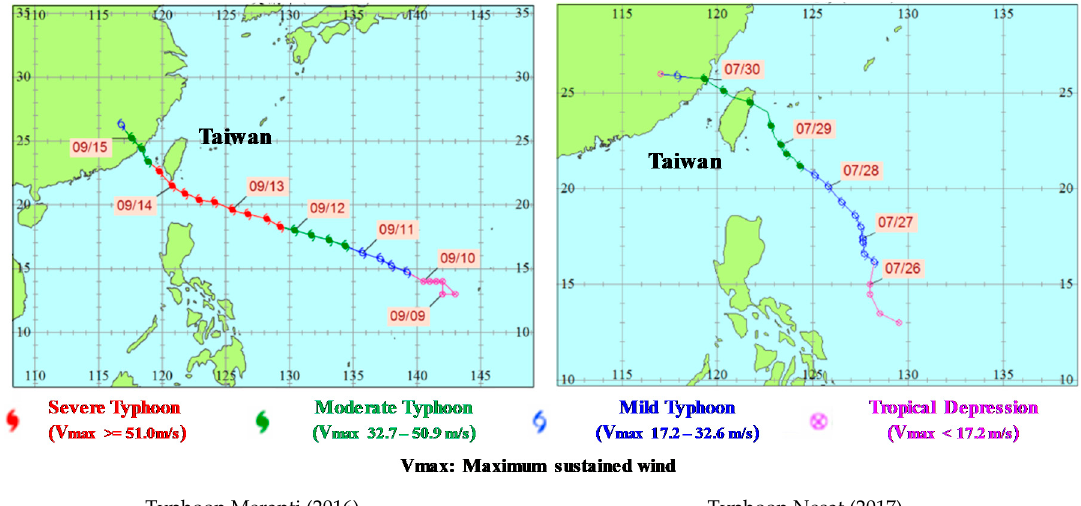
Figure 4. Tracks of Typhoon Meranti (2016) and Typhoon Nesat (2017) (CWB).